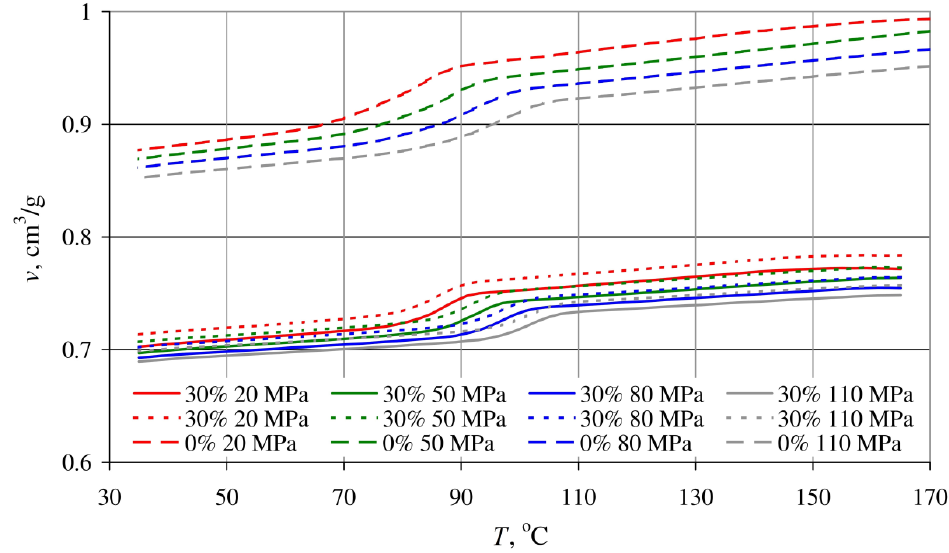
Figure 22. Dependence of the specific volume v on temperature T of a blend with a bran mass content of 30%, obtained for extruder screw rotational speeds of 50 min − 1 — solid lines and 200 min − 1 — dotted lines, and poly(butylene succinate) without added bran — dashed lines, for various pressure values.